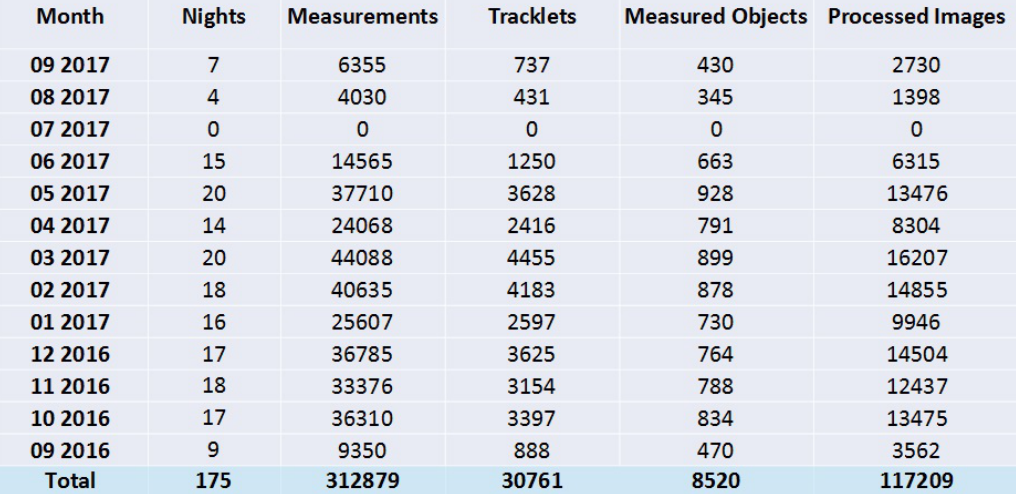
Figure 8. Statistics of ORI-25 optical measurements at Cosala, September 2016–September 2017.